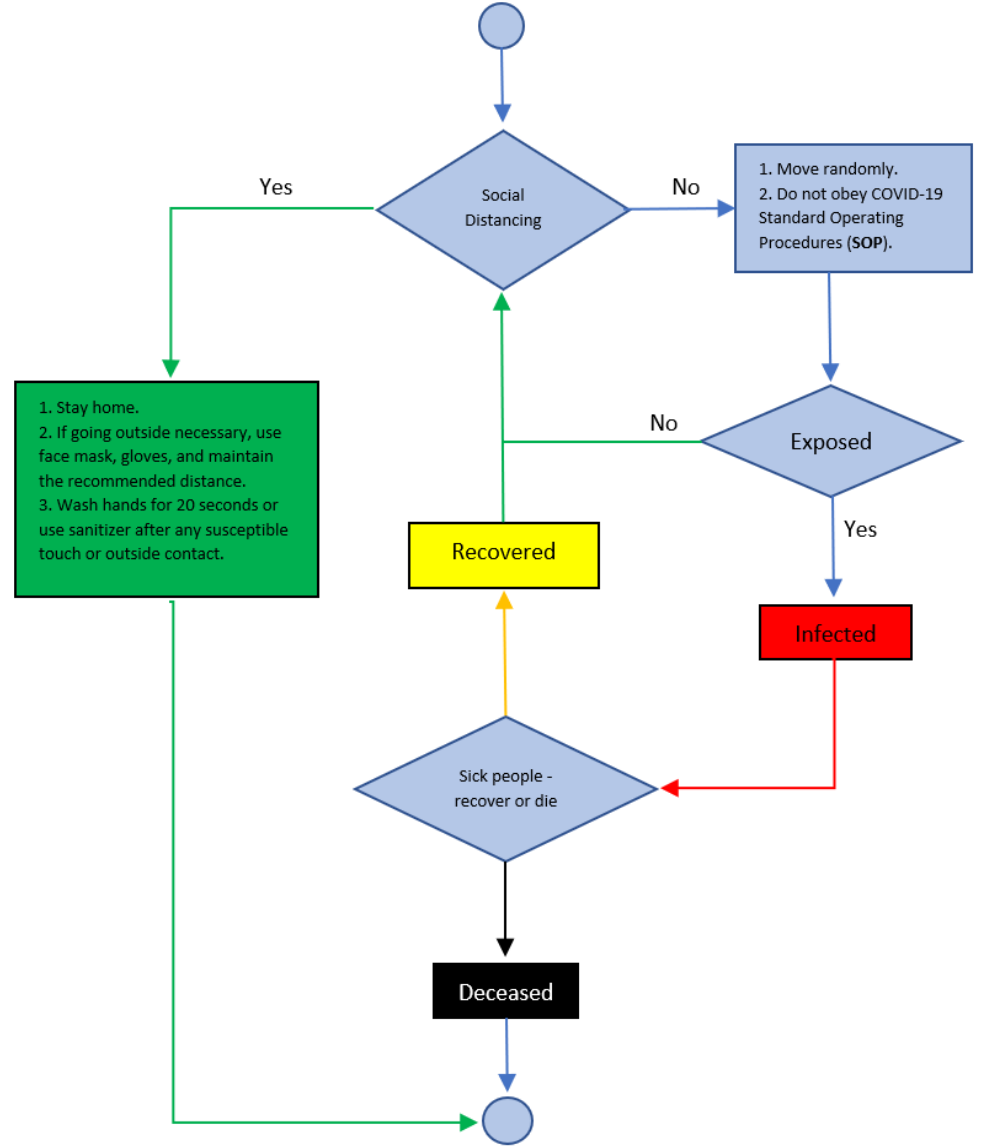
Figure 3. Process overview and scheduling.